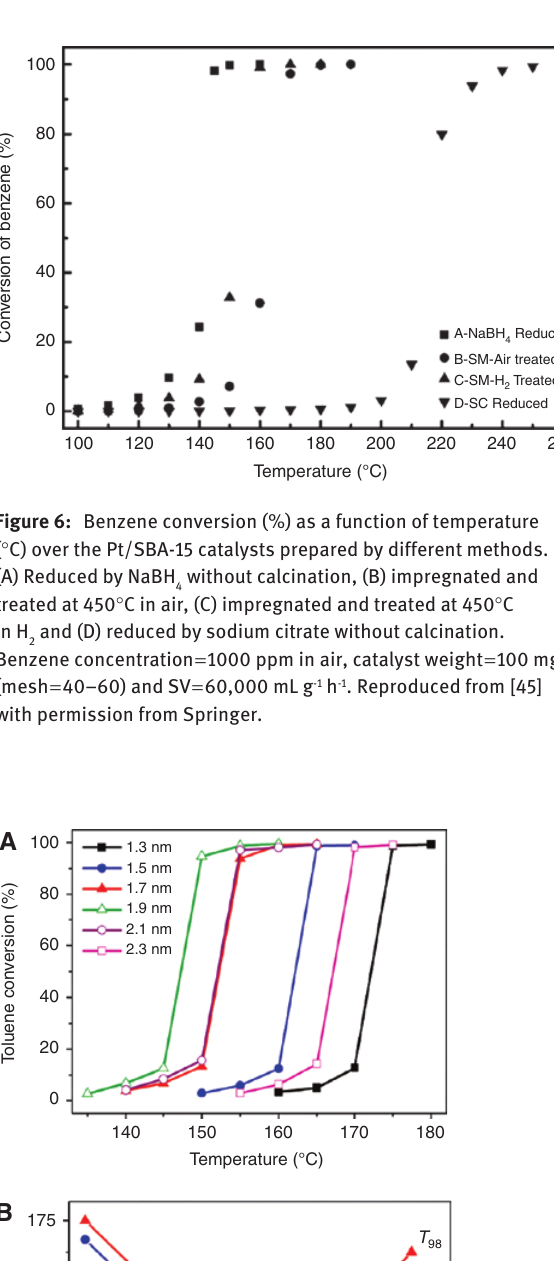
, T and T of toluene on 5 50 98